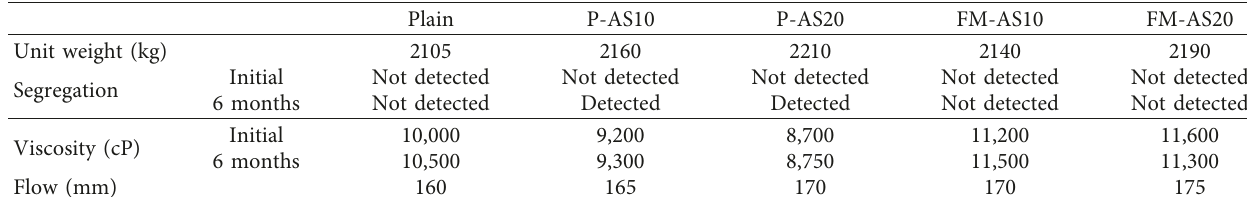
Table 12: pH and viscosity of the RMAP.